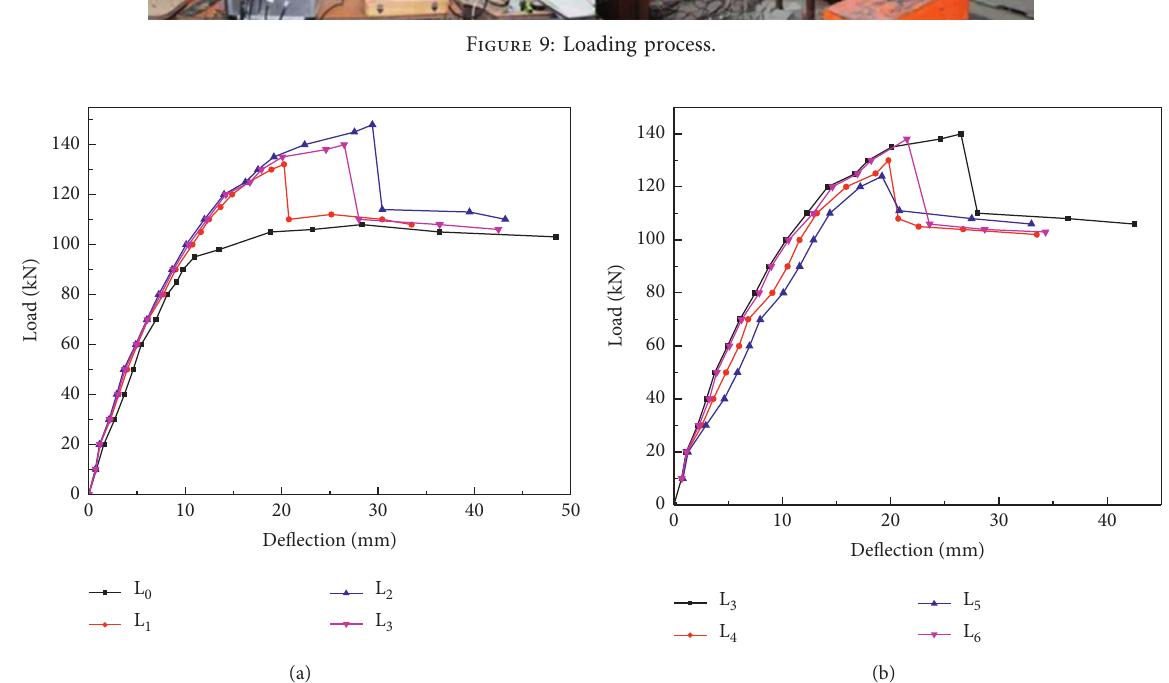
Figure 10: Load-deflection curve. (a) Beam L